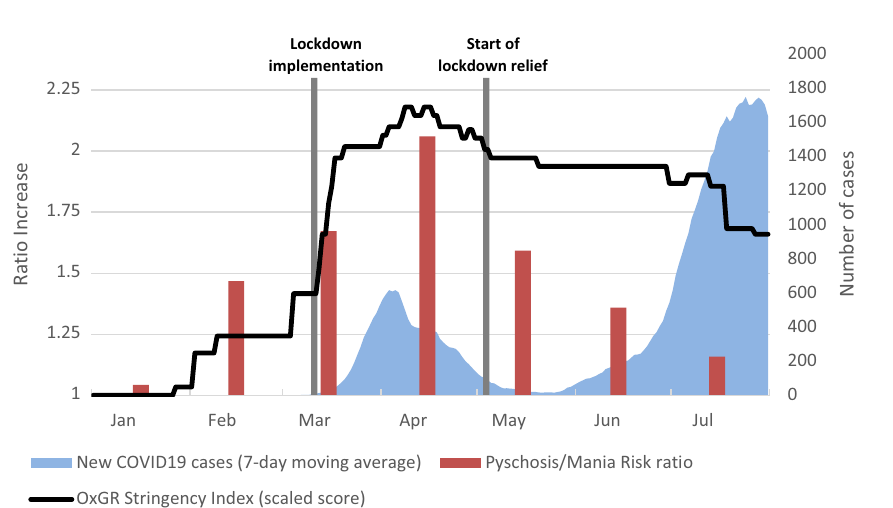
Figure 1. Monthly Risk ratio of new-onset psychosis and mania in 2019 and 2020. OxGR: Oxford Government Response Stringency Index; originally ranging 0–100, Linearly scaled in this graph to 1.00–2.25 to allow proportional presentation with the other two sets of